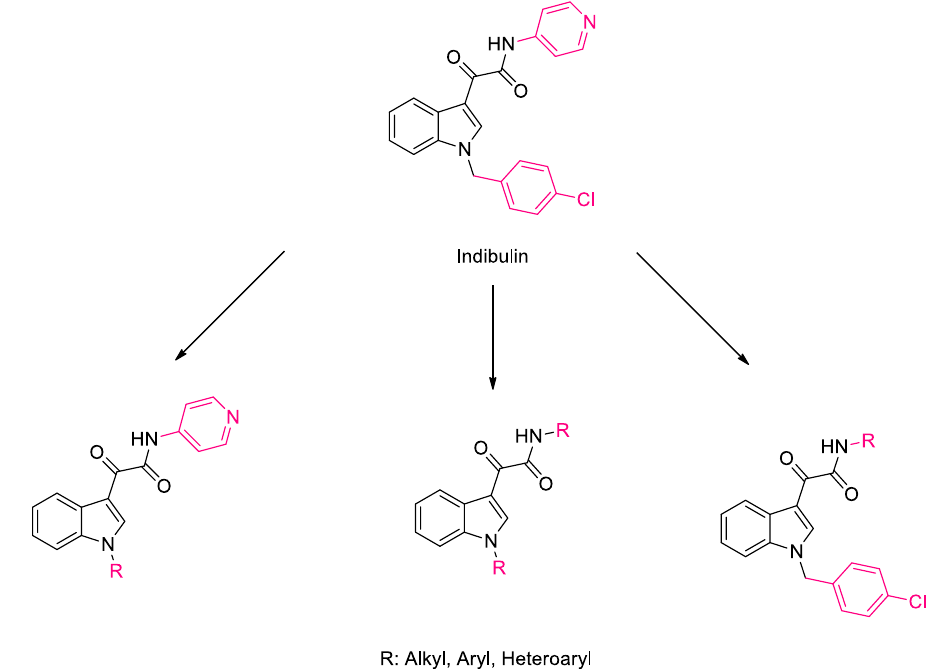
Figure 2. Structure of indibulin and modification of indibulin reported in the literature.